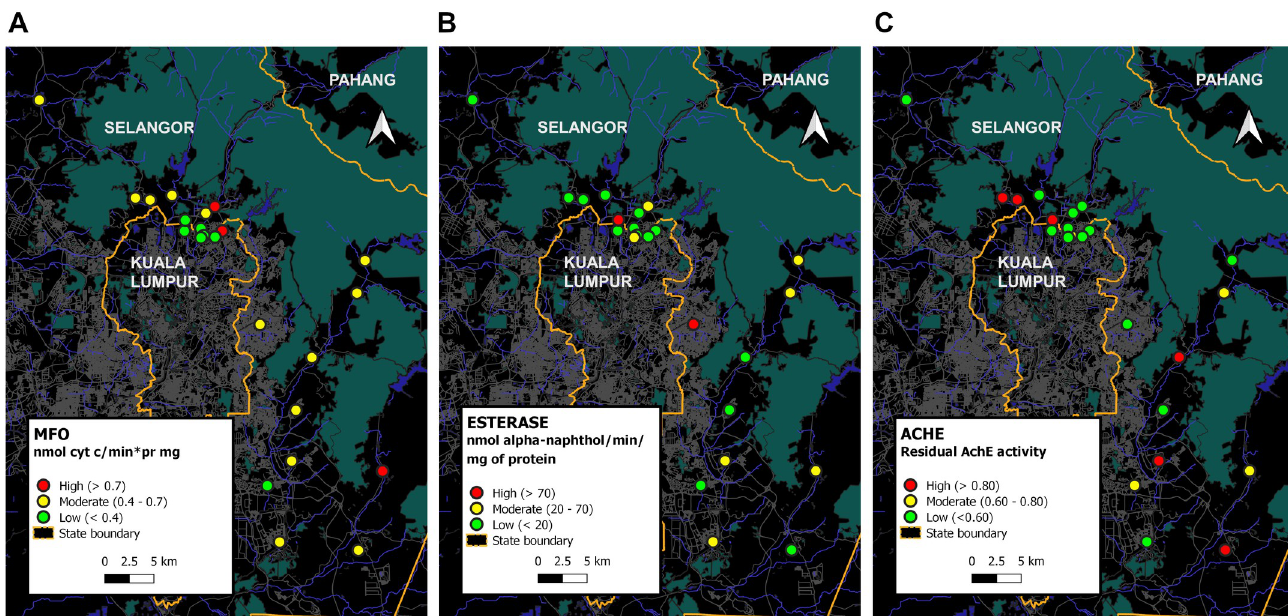
Fig 4. Enzyme Mix function oxidase (MFO), esterase and residual acetylcholinesterase (AChE) activity in collected Aedes albopictus populations.